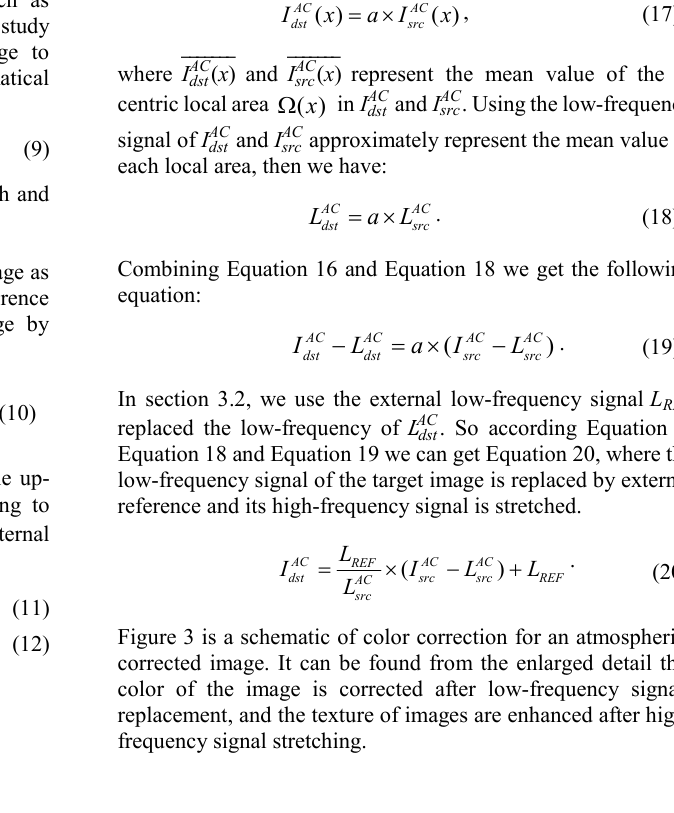
Figure 3 is a schematic of color correction for an atmospheric- corrected image. It can be found from the enlarged detail that color of the image is corrected after low-frequency signals replacement, and the texture of images are enhanced after high- frequency signal